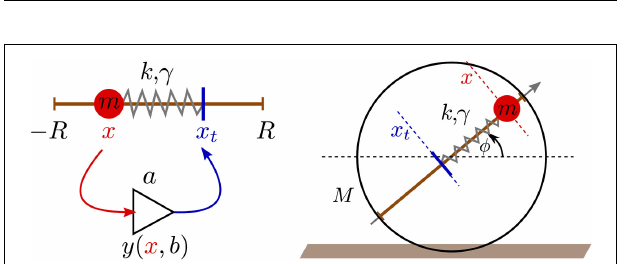
FIGURE 2 | Left: illustration of the proprioceptual single-neuron controlled damped-spring actuator. The input x of the neuron [described by equation (1)] is given by the actual position x 2 [– R, R ] of the ball of mass m moving on the rod, while the output y being proportional, via equation (2), to the target position x t of the ball. The PID controller then simulates the dynamics of a damped spring, with constant k and damping γ , between the current and the target positions of the mass. Right: sketch of the one-rod robot composed of a barrel of mass M and radius R , with a mass m moving along a rod, as illustrated in the left panel. Slipping is not allowed, the robot moves hence with a velocity v b = R ω = R ( d ϕ = dt ), where ϕ measures the angle of the rod with respect to the